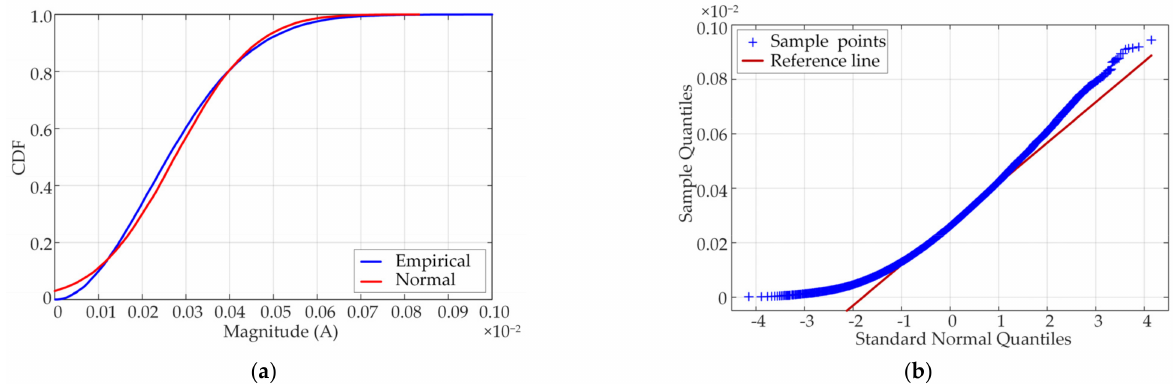
Figure 4. The frequency-domain distribution without supraharmonic signals. ( a ) Cumulative distribution function (CDF) curve of the normal and empirical distribution; ( b ) Data distribution quantile–quantile (Q–Q)